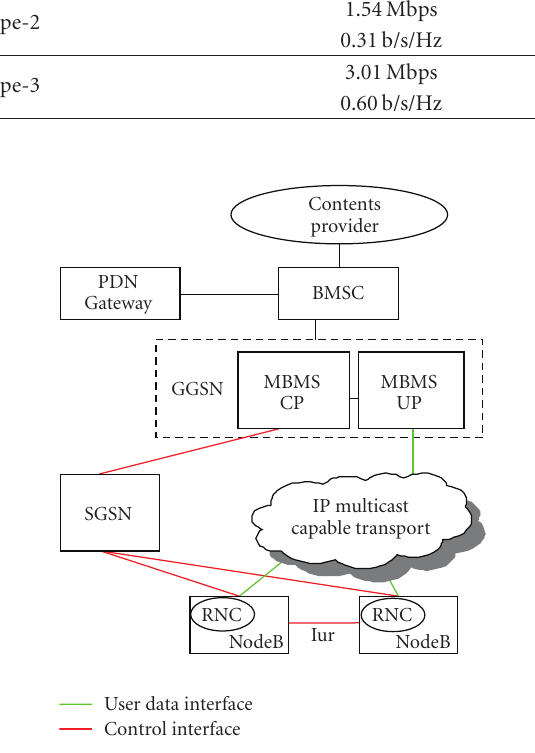
Figure 18: Architecture for MBMS in SAE/UTRA flat